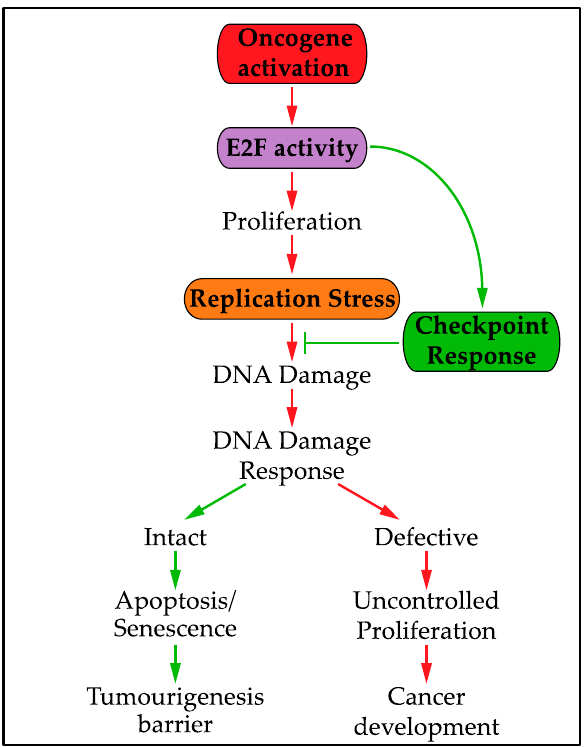
Figure 4. Many oncogenes deregulate E2F activity, thereby driving S phase entry and uncontrolled proliferation, resulting in oncogene-induced replication stress and DNA damage. The DNA damage response acts as an initial barrier to tumourigenesis, but replication stress causes genome instability driving mutations that bypass the DNA damage checkpoint. However, E2F activity is also required for tolerance to oncogene-induced replication stress to prevent DNA damage.